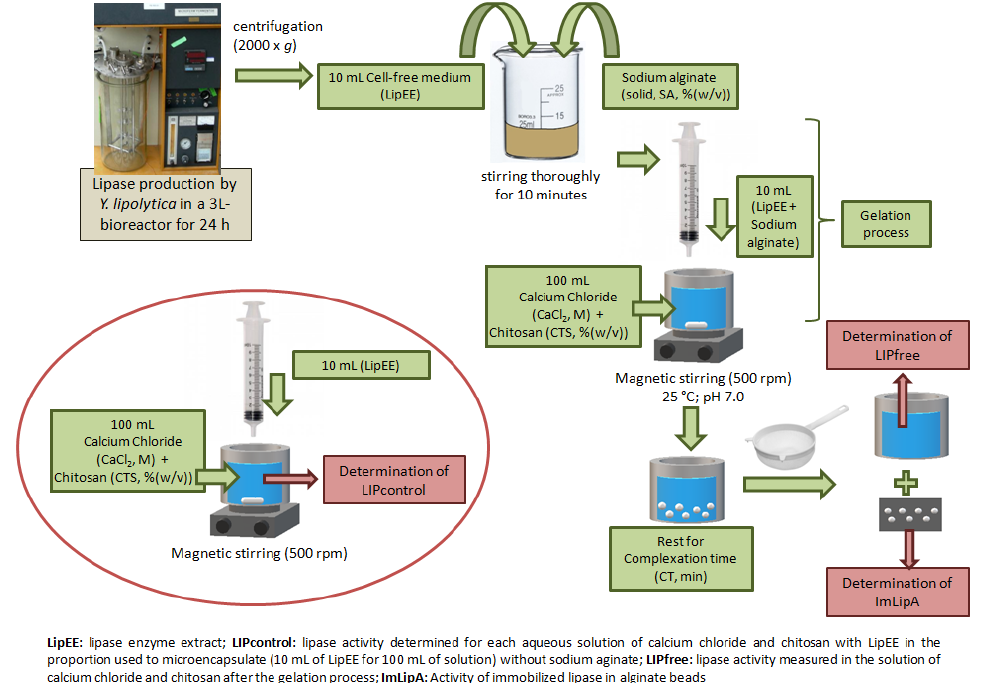
Figure 7. Scheme of microencapsulation process. Sodium alginate concentration (SA), chitosan concentration (CTS), calcium chloride concentration (CaCl 2 ) and complexation time (CT).